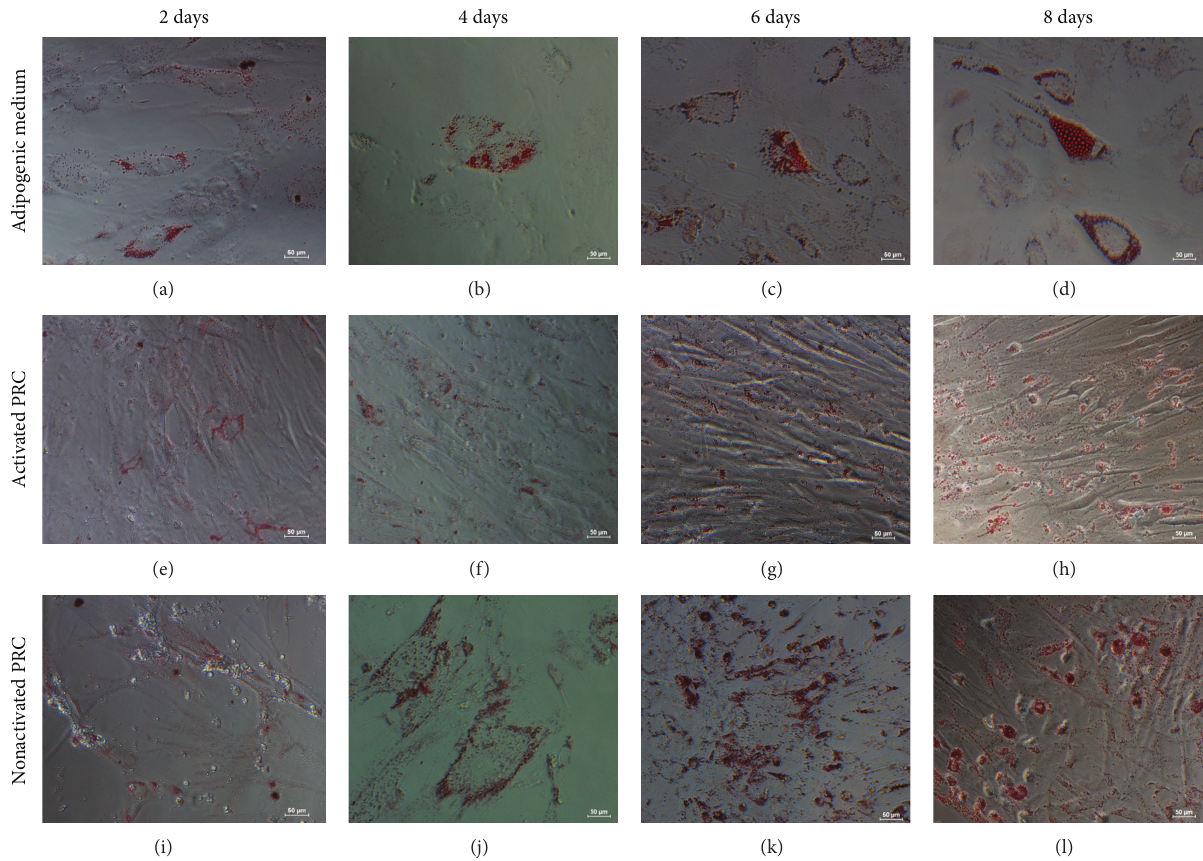
Figure 7: Cells stained with Oil Red O. Cells cultured in adipogenic medium (a)–(d), activated PRC (e)–(h), and nonactivated PRC (i)–(l). Cells cultured in PRC were fixed with formalin after each time point and were stained with Oil Red O. Cells cultured in adipogenic medium served as the positive